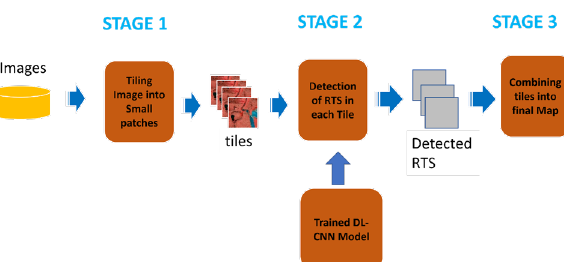
Figure 9 . Semantic diagram of high-resolution satellite imagery